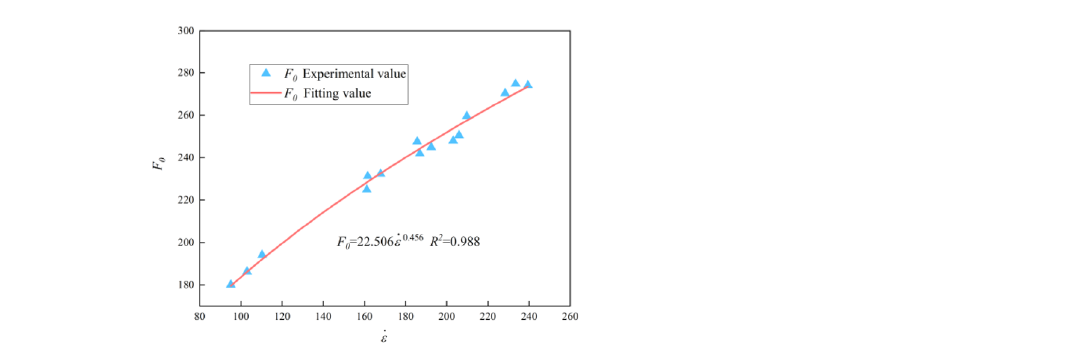
Figure 14. Fitting relationship between F 0 and strain